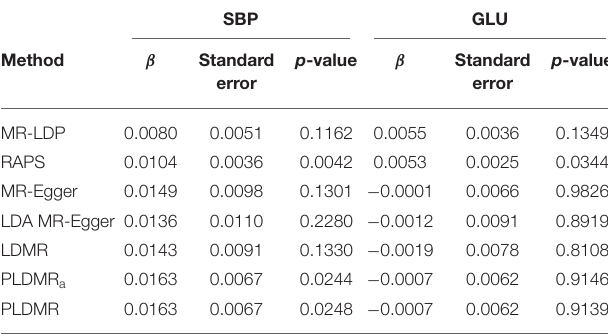
TABLE 1 | Causal inference of BMI on SBP and GLU, respectively, in analyzing ARIC